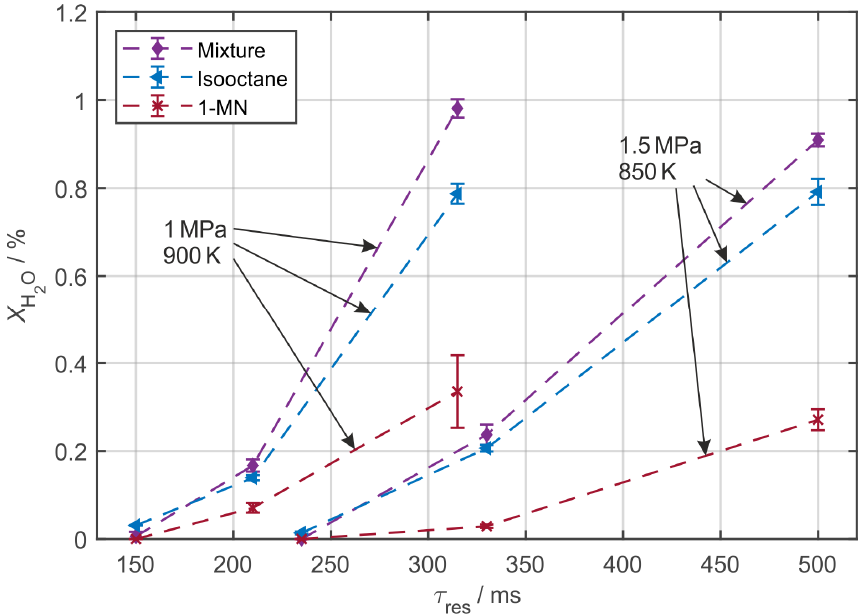
Figure 4. Residence time variation for 1 vol. % 1-MN in isooctane, pure isooctane and 1-MN for two operating points ( AFR = 1).